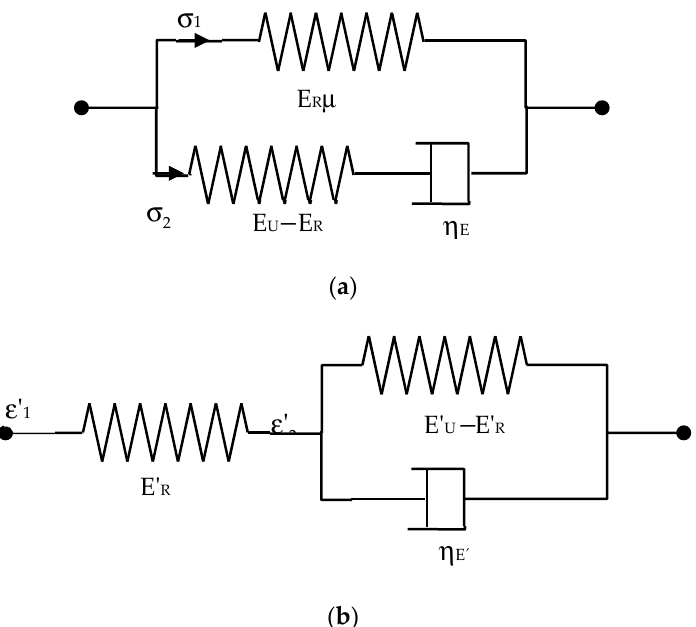
Figure 1. Standard solid model representing electromechanical behaviour: ( a ) spring in parallel with a Maxwell element, (useful for strain inputs); ( b ) spring in series with a Kelvin-Voigt element (useful for stress inputs).